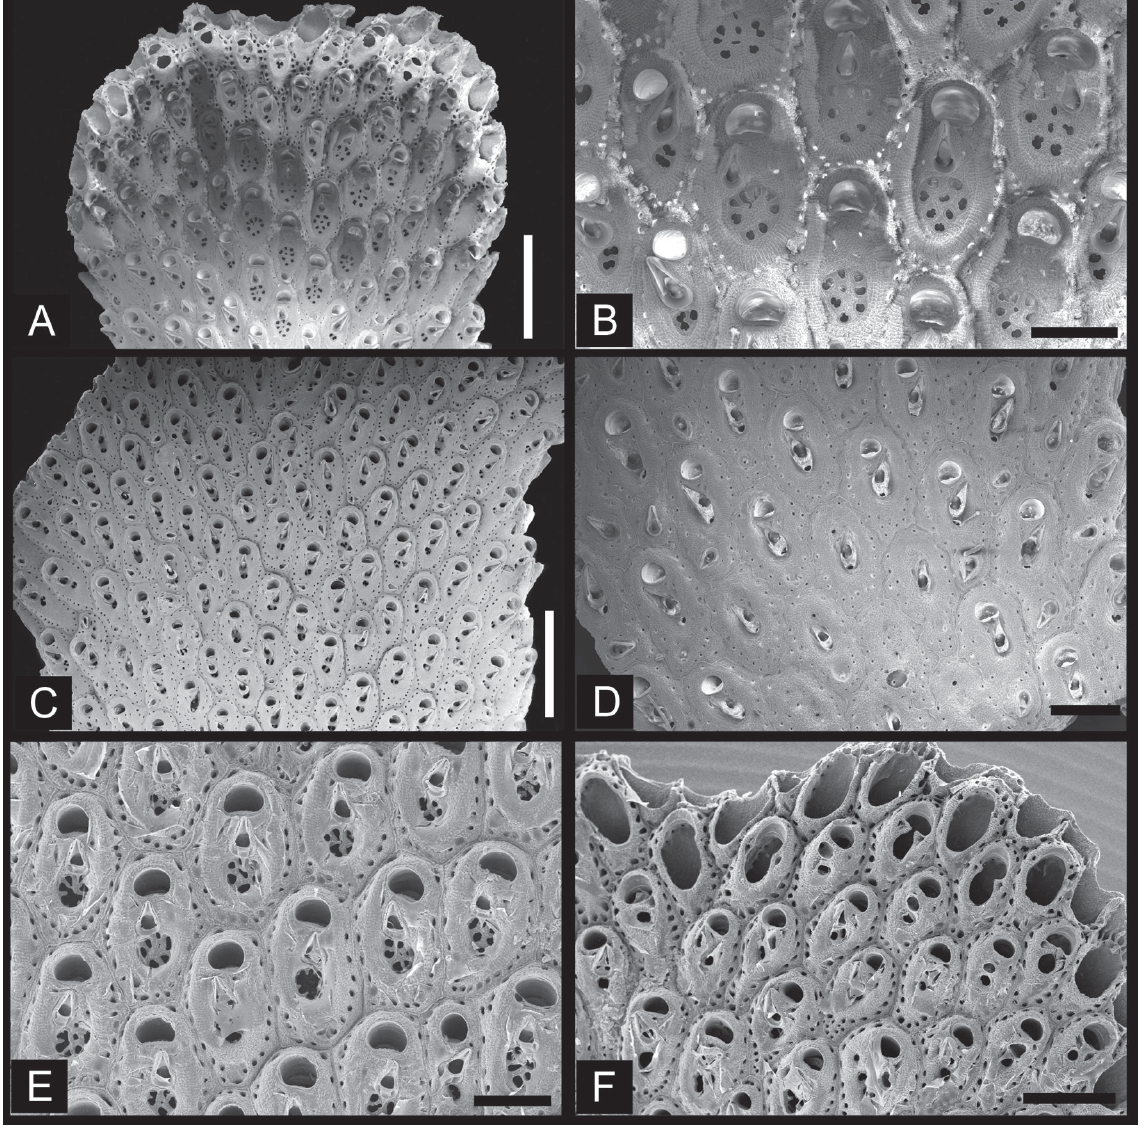
Fig. 8. Adeonellopsis japonica (ortmann, 1890) . A . Distal end of branch just starting to bifurcate, showing young autozooids and gonozooids (NsMT-Bryr277). B . enlargement of young gonozooids, showing peripheral rim with rows of granulation perpendicular to margin, and large multiporous spiramen (NsMT-Bryr277). C . Autozooids in middle of branch, showing immersed spiramen (NsMT- Bry r 193). D . Basal part of branch, showing autozooids, and some kenozooids with closed orifice (NsMT-Bryr36). E . Young gonozooids, showing distinct marginal pores and multiporous spiramen (NsMT-Te758). F . Distal end of branch, showing autozooid formation (NsMT-Te758). seM images. Scale bars: A, C = 1 mm, B, D–E = 300 μm; F = 500